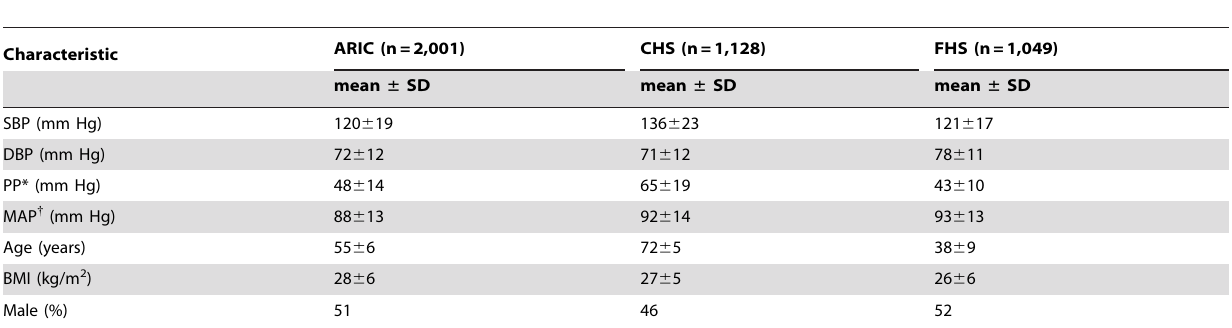
Table 1. Characteristics of the study